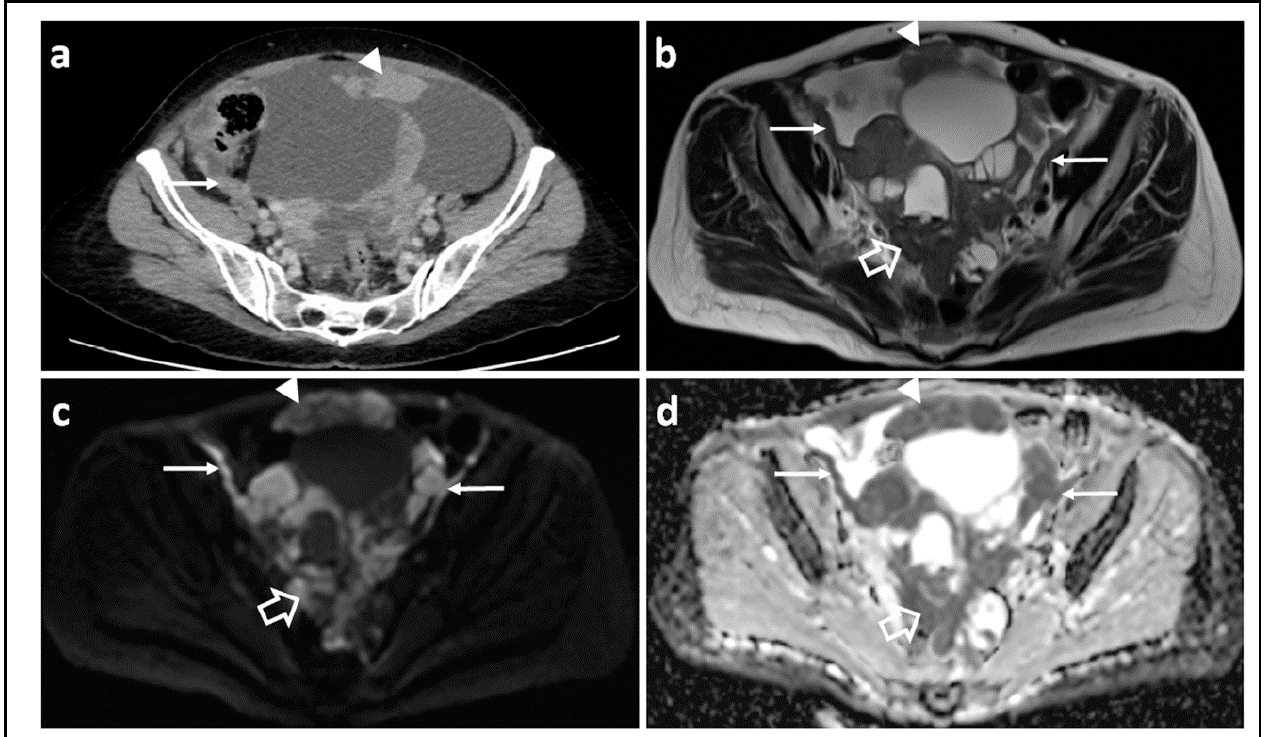
Figure 3. Assessing disease extent using CT versus MRI: CT scan ( a ) T2-W image ( b ) and corre- sponding b = 1050 s/mm 2 DW-MRI ( c ) and ADC map ( d ) through the mid-pelvis in a patient with high grade serous ovarian cancer before treatment. The peritoneal (arrow) and omental disease (arrowhead) is evident in ( a ), but the extent of peritoneal and serosal disease encasing the sigmoid colon is more striking on MRI (open arrows) where it appears as high signal within the pelvis in ( c ). Marked diffusion restriction is confirmed in ( d ).